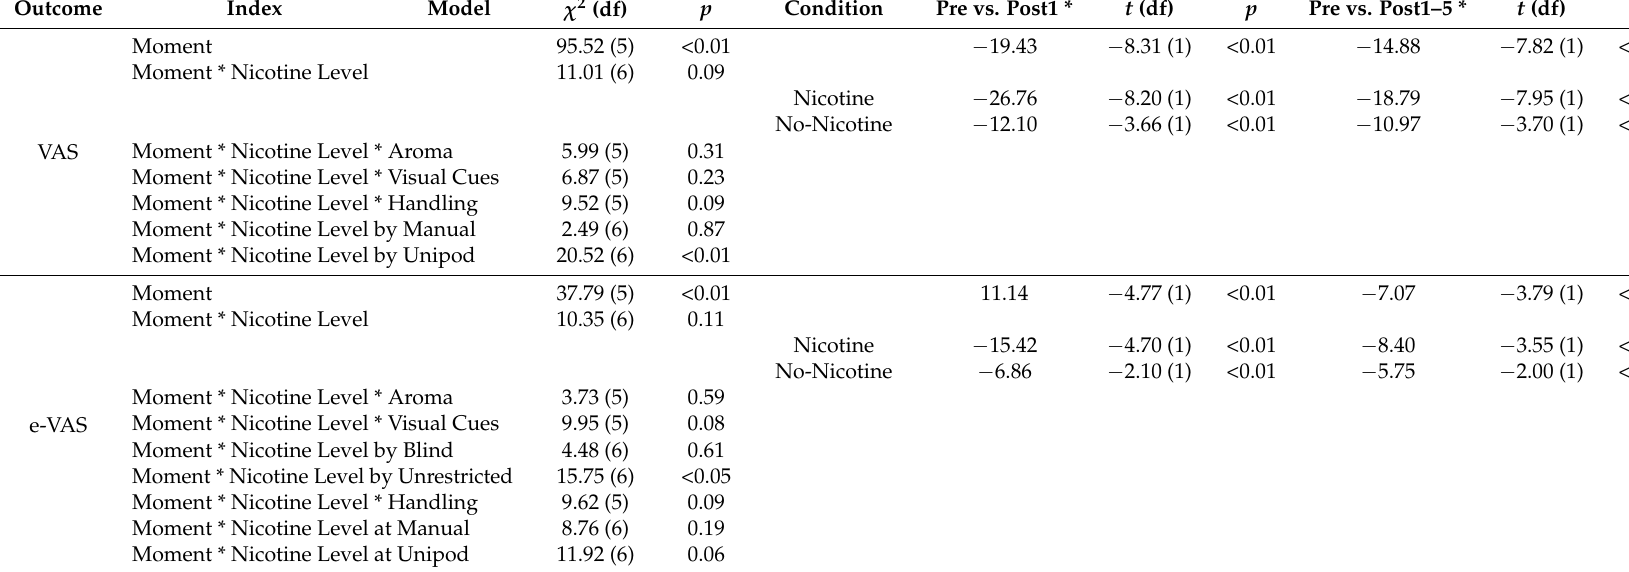
Table 2. Results of the mixed-effects models with respect to visual analogue scale (VAS) and e-VAS.